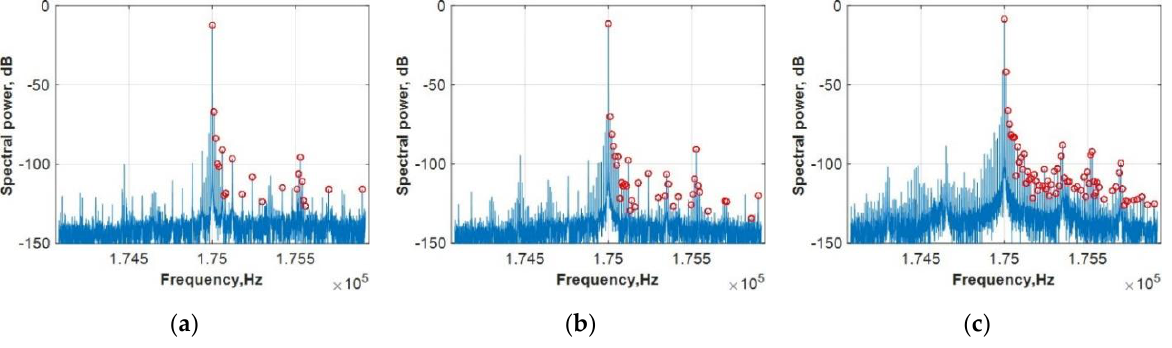
Figure 4. Spectra in the frequency window of 2000 Hz around the probe frequency f = 175 KHz for Sample #3: ( a ) after 11,252 load cycles, no damage initiation; ( b ) after 47,139 cycles, initial damage accumulation; ( c ) after 51,219 cycles, visible crack. The number of cycles to failure was 52,106 (see Table 2).